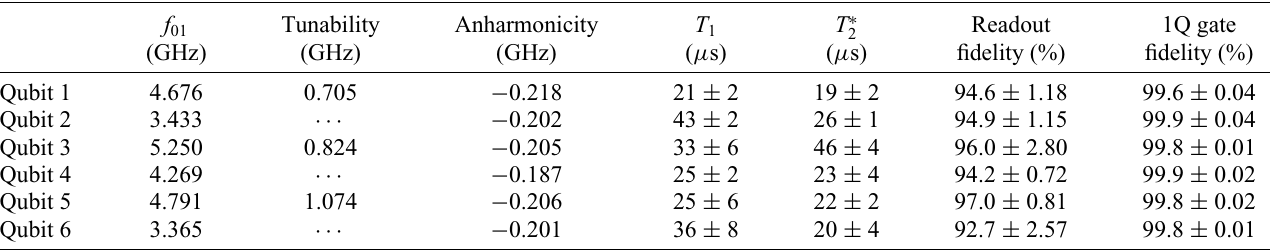
TABLE I. Relevant information about the qubits used in the experiments described in this manuscript. Qubits 1 and 2 are capacitively coupled neighbors, as are qubits 3 and 4 and qubits 5 and 6 on different devices. The indexing labels used here are for convenience and are not representative of positioning within a lattice. The listed f 01 values correspond to bias (cid:2) dc = 0, and represent the maximum of each qubit’s tunability band. Tunabilities are only listed for the qubit in each pair that is modulated to activate entangling gates. Listed values represent coherence times measured with (cid:2) dc = (cid:2) ac = 0, anharmonicities correspond to f 12 − f 01 at (cid:2) dc = 0. Listed T 1 and T ∗ 2 when qubits are biased at their maximum frequencies and are not being modulated. Listed readout fidelities represent the average of classification probabilities P ( 0 | 0 ) and P ( 1 | 1 ) measured nonsimultaneously across qubits. Listed single-qubit (1Q) gate fidelities are measured with randomized benchmarking, performed nonsimultaneously across